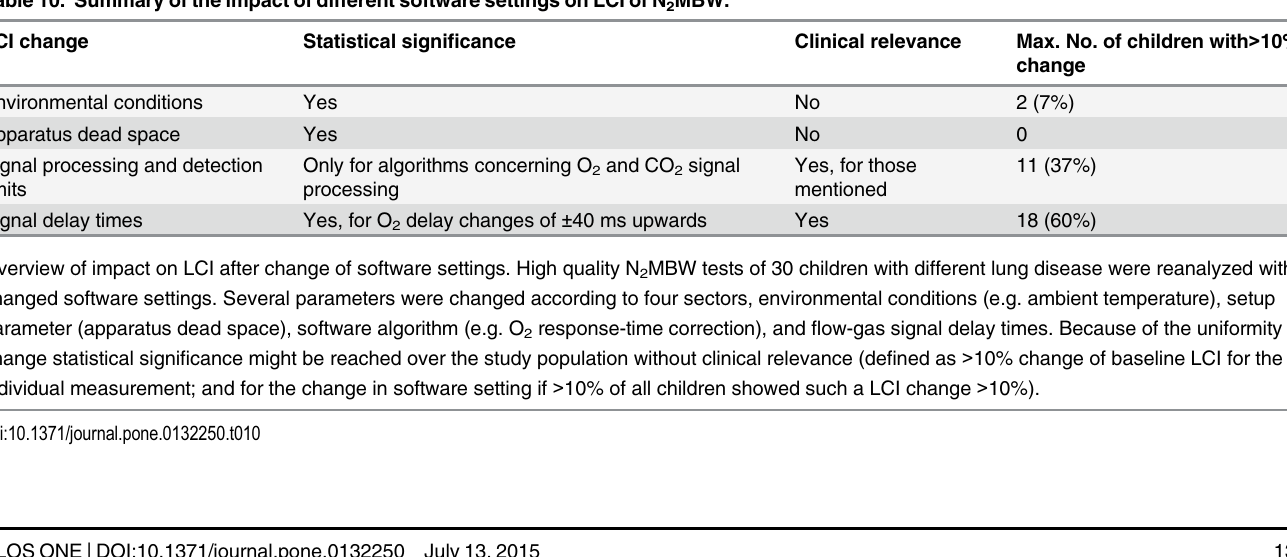
Table 10. Summary of the impact of different software settings on LCI of N 2 MBW. LCI change Statistical signi fi cance Clinical relevance Max. No. of children with > 10% Environmental conditions 2 (7%) Apparatus dead space Signal processing and detection Only for algorithms concerning O 2 and CO 2 signal processing limits Signal delay